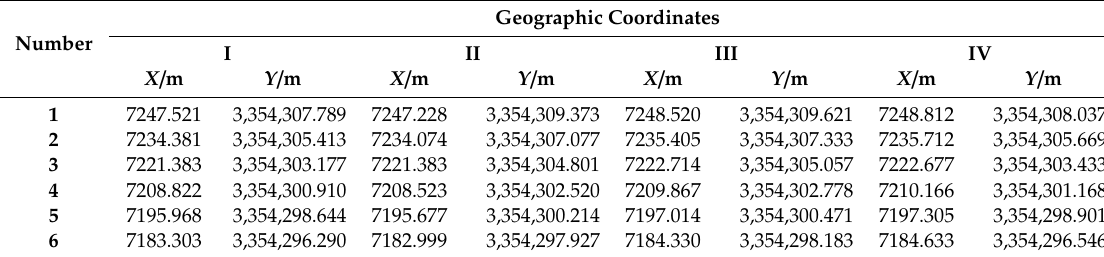
Table 5. Coordinates of obstacles extracted by template matching algorithm.